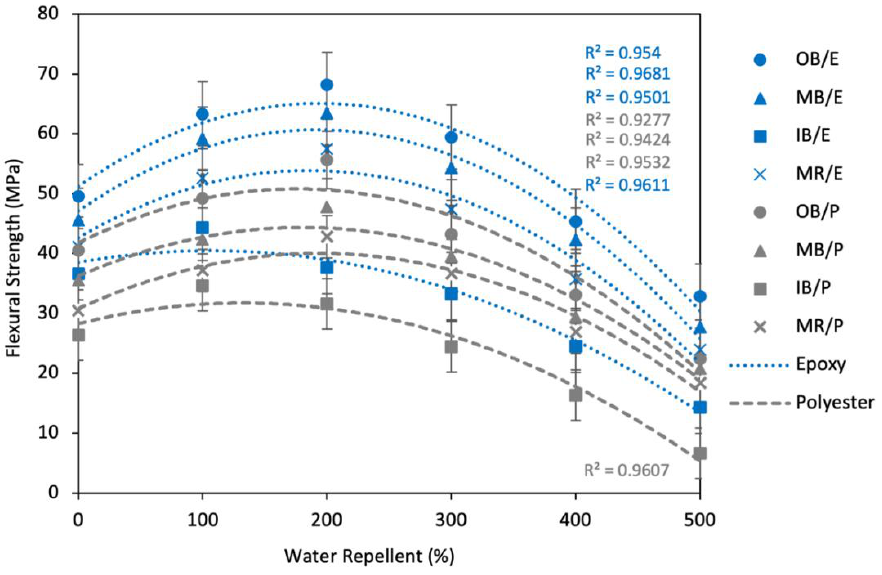
Figure 16. Effect of gamma radiation on the flexural strength of the composites.